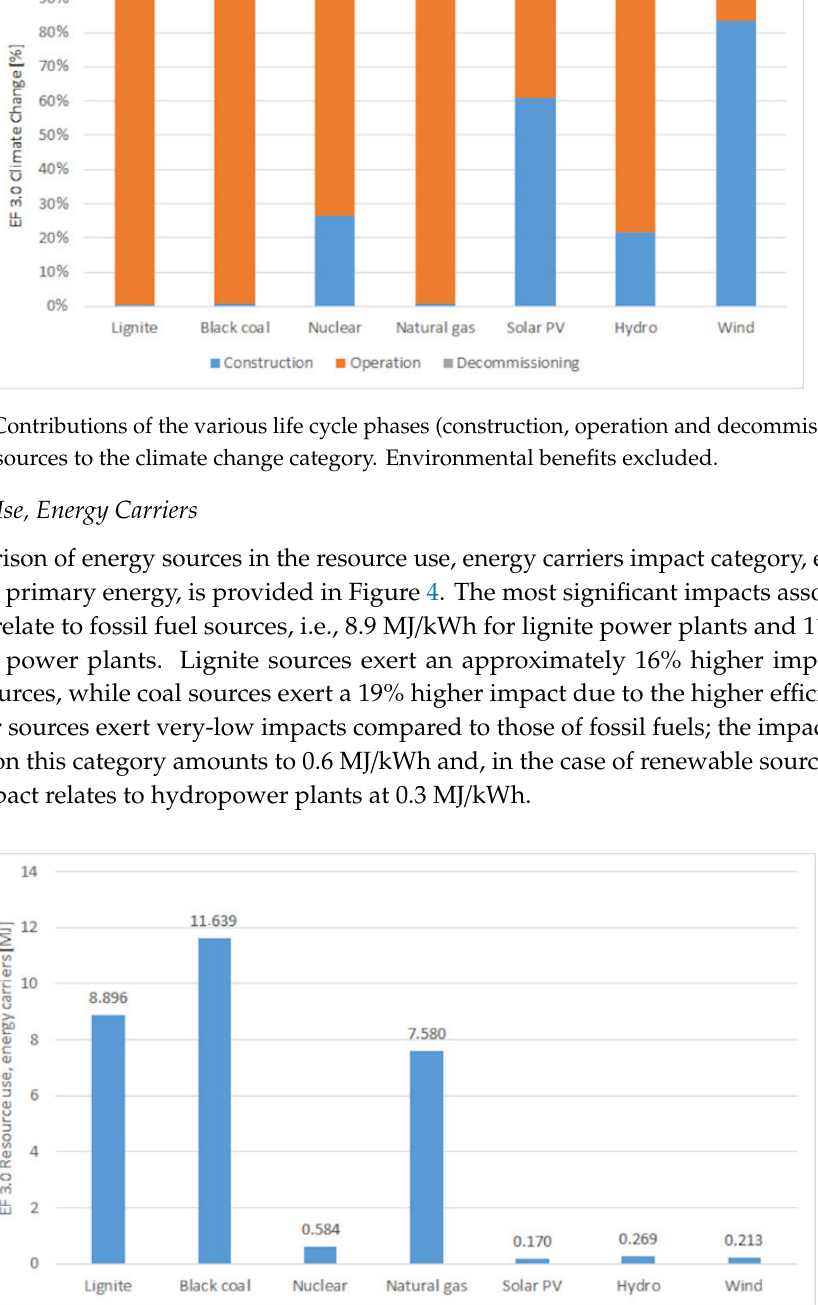
Figure 4. Environmental impacts of selected energy sources on the resource use, energy carriers category. The results related to 1 kWh of electricity supplied to the grid. The results are expressed in MJ of primary energy.